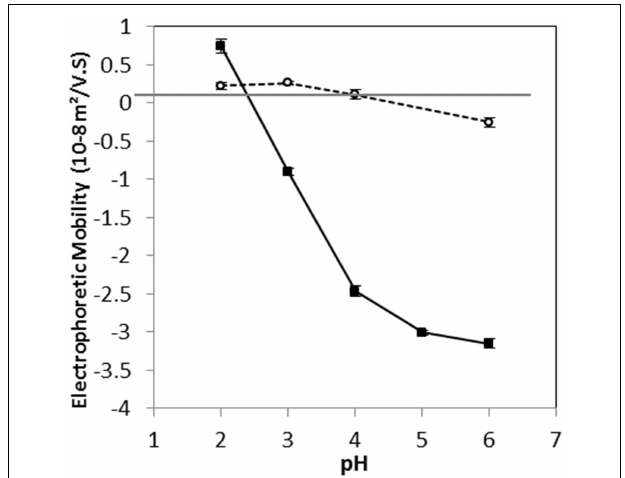
FIGURE 2 | Variation of electrophoretic mobility as a function of pH for Lactococcus lactis LD61 (circles) and TIL1230 (squares). Cells were harvested in the stationary growth phase. Measurements were made in 1mM KNO 3 solution on two independent sets of data; the bars represent the standard deviations of mean